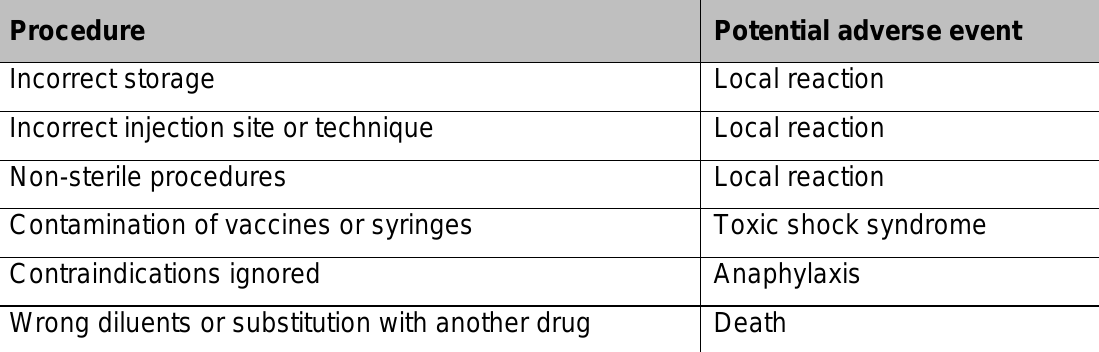
Table 2. Inappropriate procedures and associated adverse